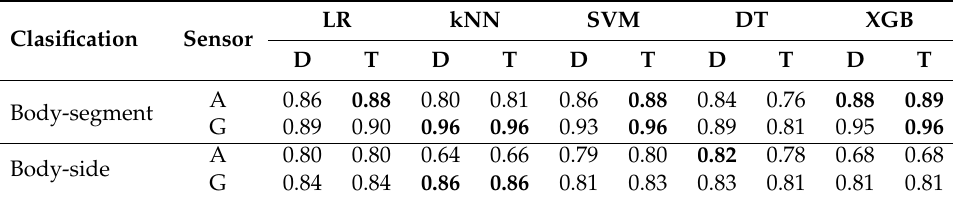
Table 3. Result of optimized classifiers for body-segment, body-side